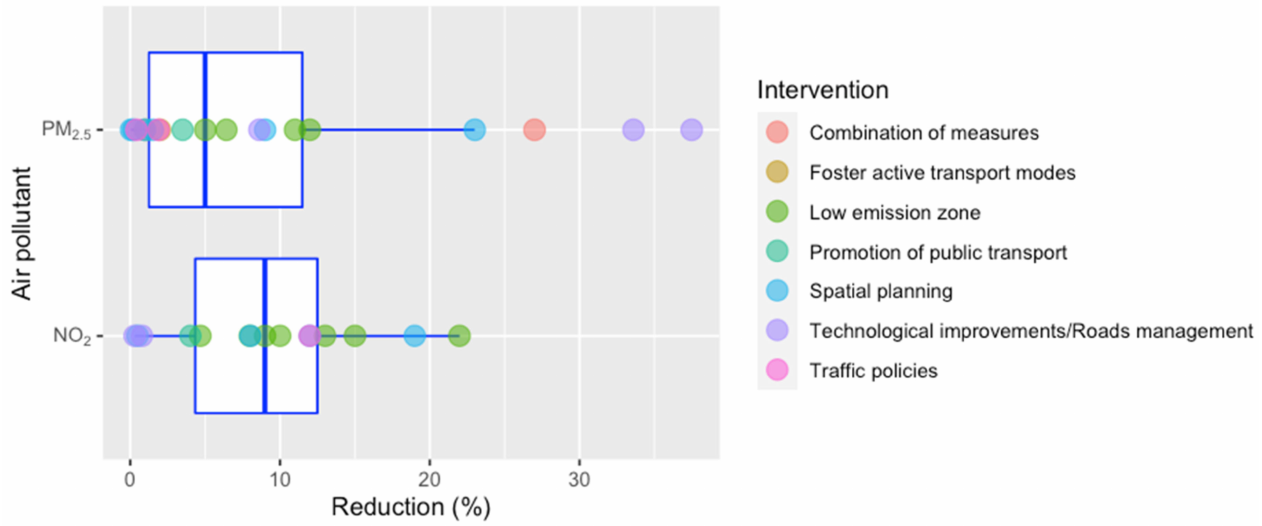
Figure 2. Summary of the results of the review on studies assessing the effectiveness of different abatement measures against traffic emissions (as reported in Table